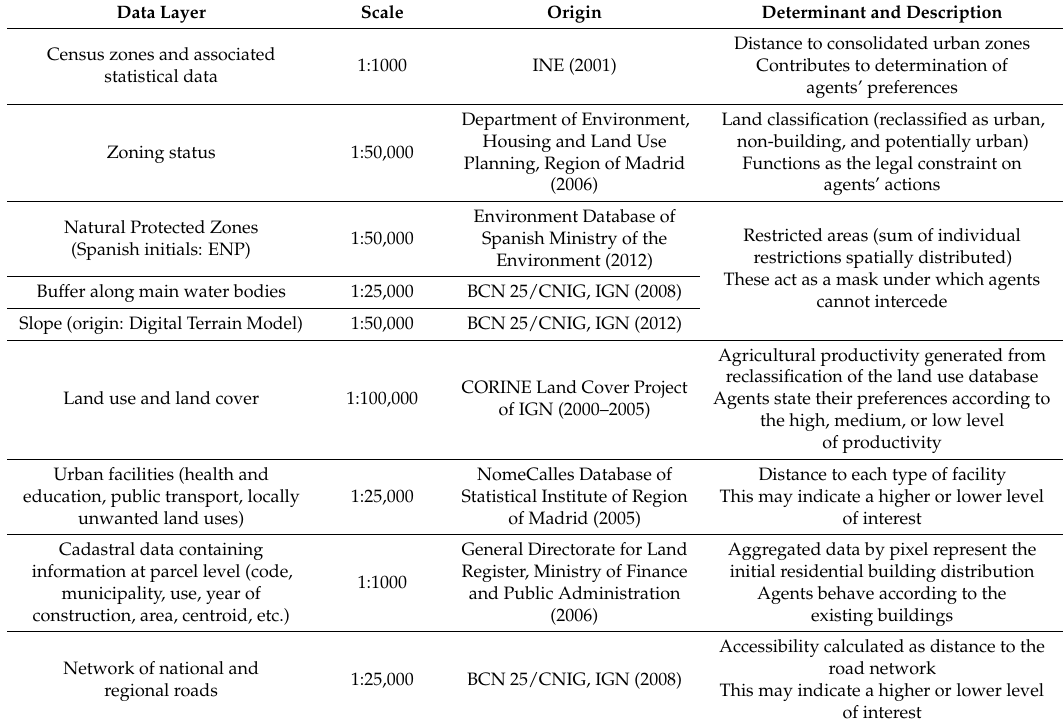
Table 1. Description of determinants, based on input data, incorporated into the prototype. Data Layer Scale Origin Determinant and